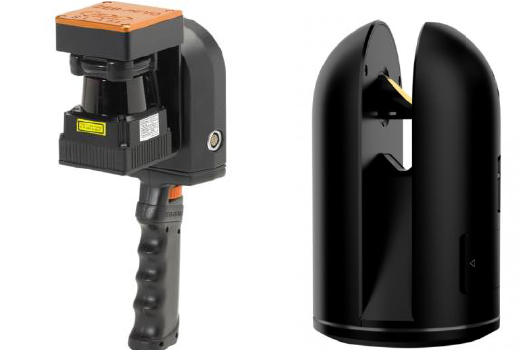
Figure 2. Ruins of the Grand Khan in Koysanjaq historical Figure 3. Illustration of the Zeb-revo handheld SLAM scanner center (left) and laser scanner BLK360